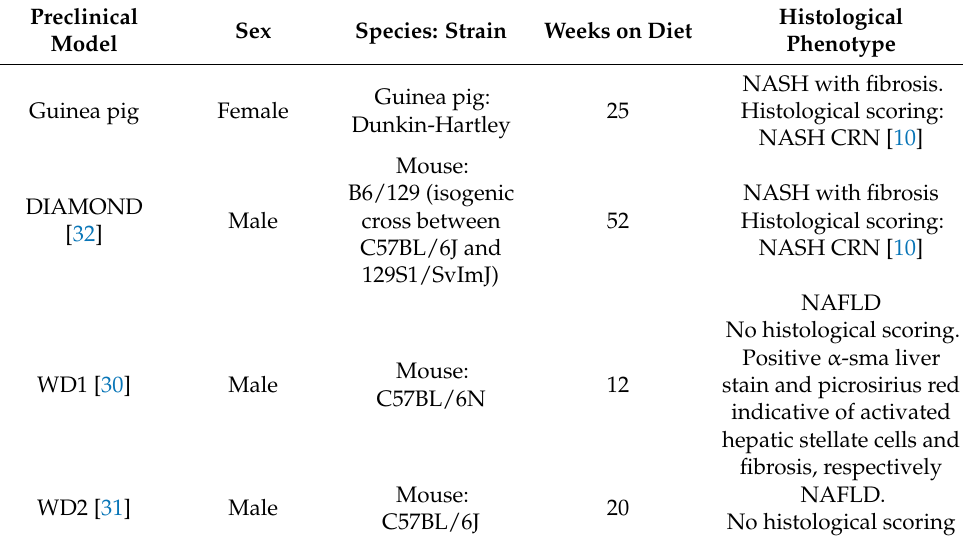
Table 1. Overview of included preclinical